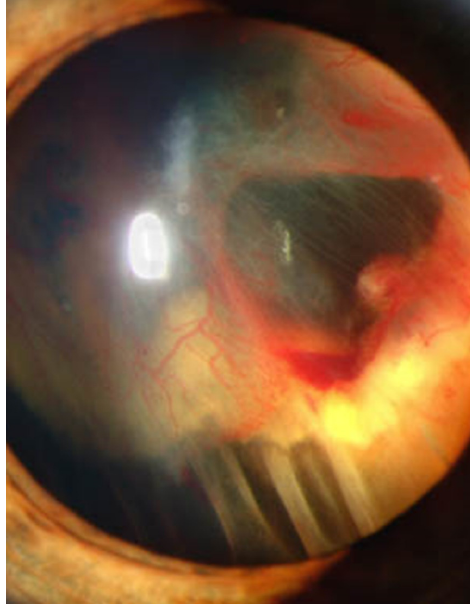
Figure 1. Slit lamp photograph showing retinal detachment in VHL disease. Credit: National Eye Institute, National Institutes of Health Ref#: EDA08 (This image is a work from the National Institutes of Health, a part of the United States Department of Health and Human Services, taken or made as part of an employee's official duties. As a work of the U.S. federal government, the image is in the public domain).